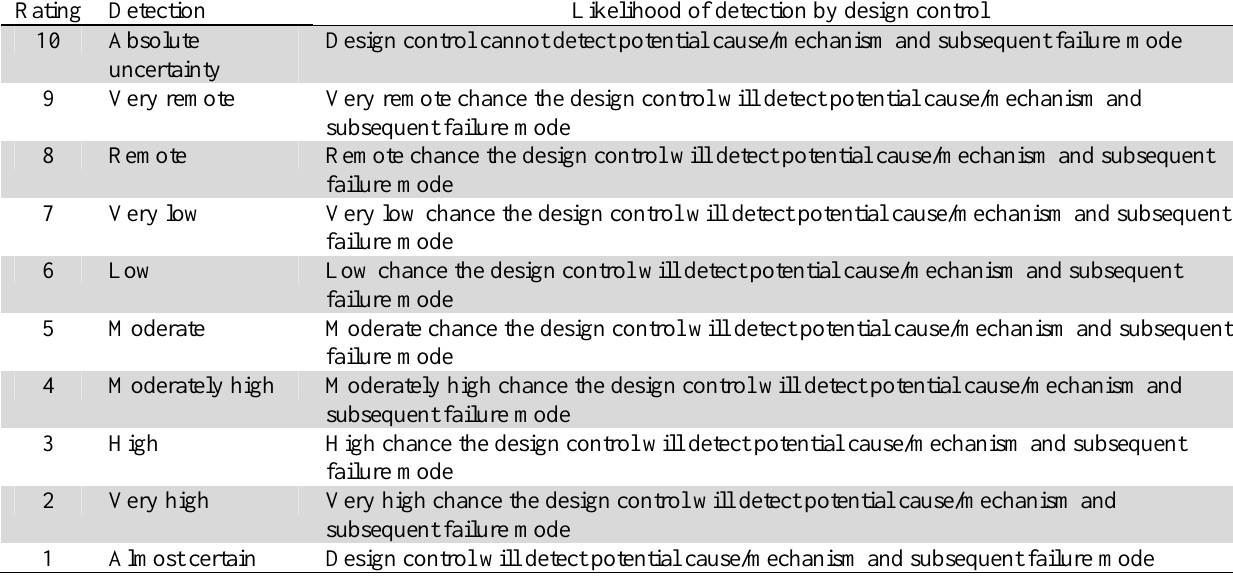
Table 3 Crisp ratings for detection of a failure (Chin et al., 2008; Wang et al.,